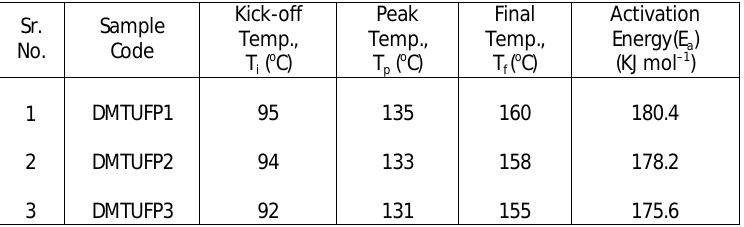
Table 4Table 4.. TGA of unreinforced DMTUFP : HMTA cured materials.